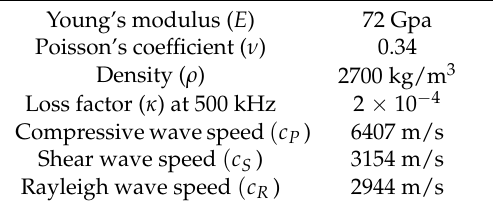
Table 1. Properties of aluminium used in the